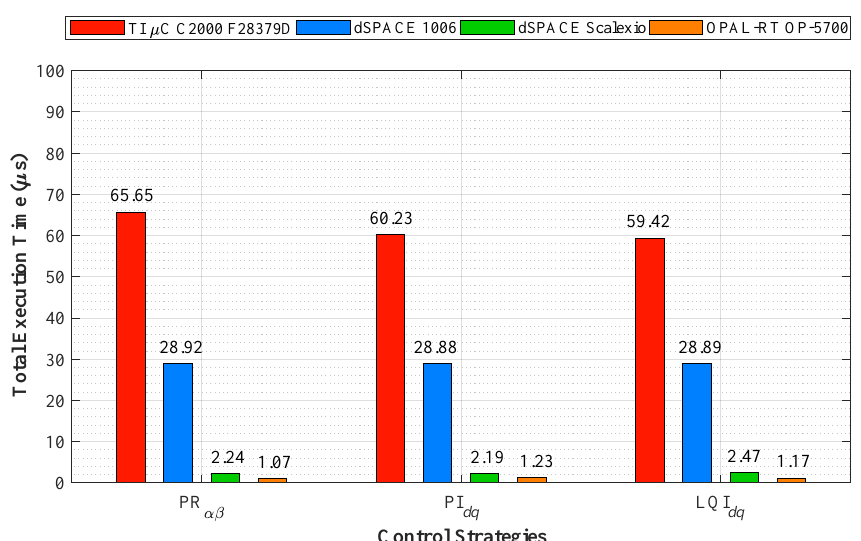
Figure 19. Time profiling for debugged block